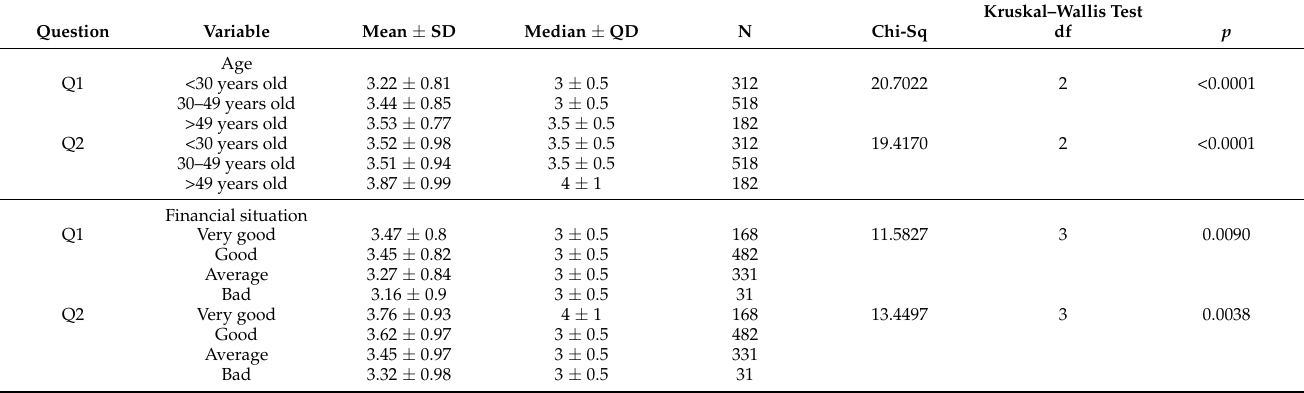
Table 7. Comparison of the answer of the given question (Q1, Q2) with age and financial situation.